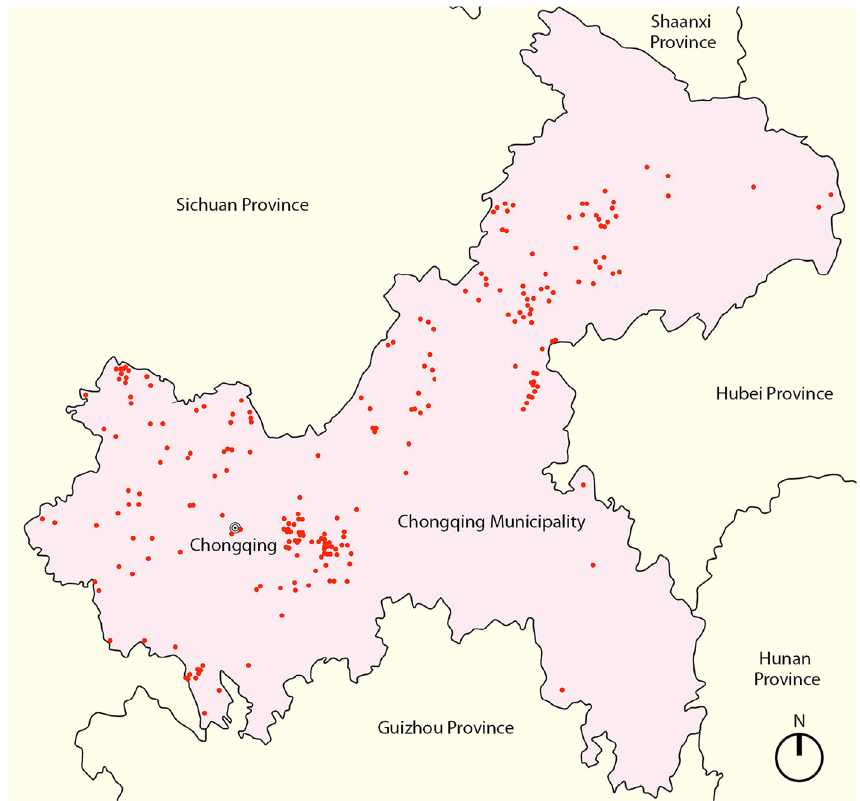
Fig. 5 Distribution of watchtower buildings in the districts and counties of Chongqing (Source: the author and Zhiwei Liu, based on data from China’s 3rd cultural relics census of 2011 and the author’s survey data of Chongqing from 2015 to 2019. Approval code of the background map: GS[2019]3266, by National Bureau of Surveying and Mapping Geographic